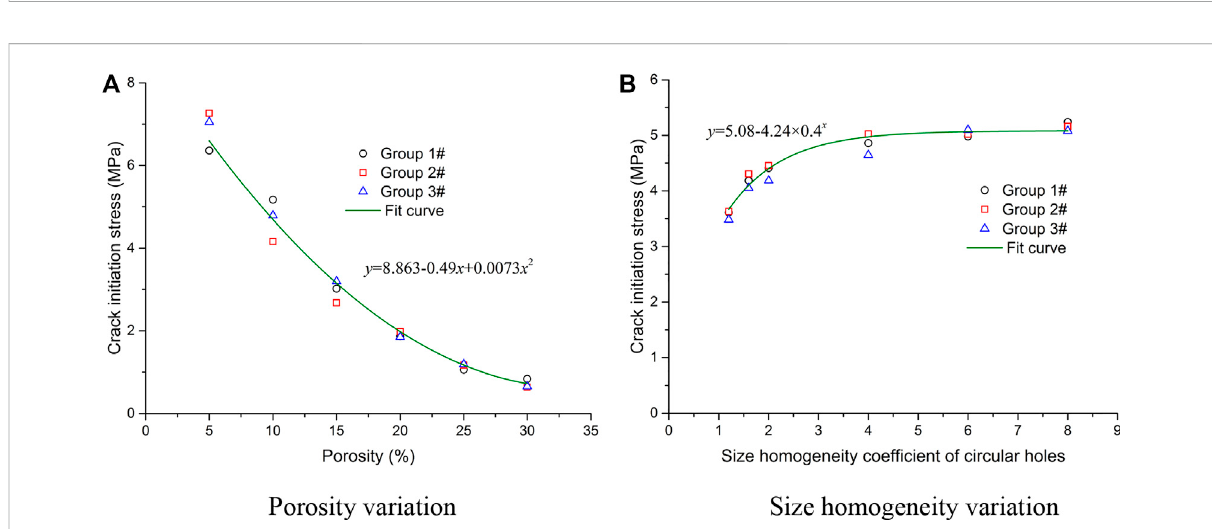
FIGURE 18 Fitting results of the CI stress values of the models containing random circular defects. (A) Porosity variation (B) Size homogeneity